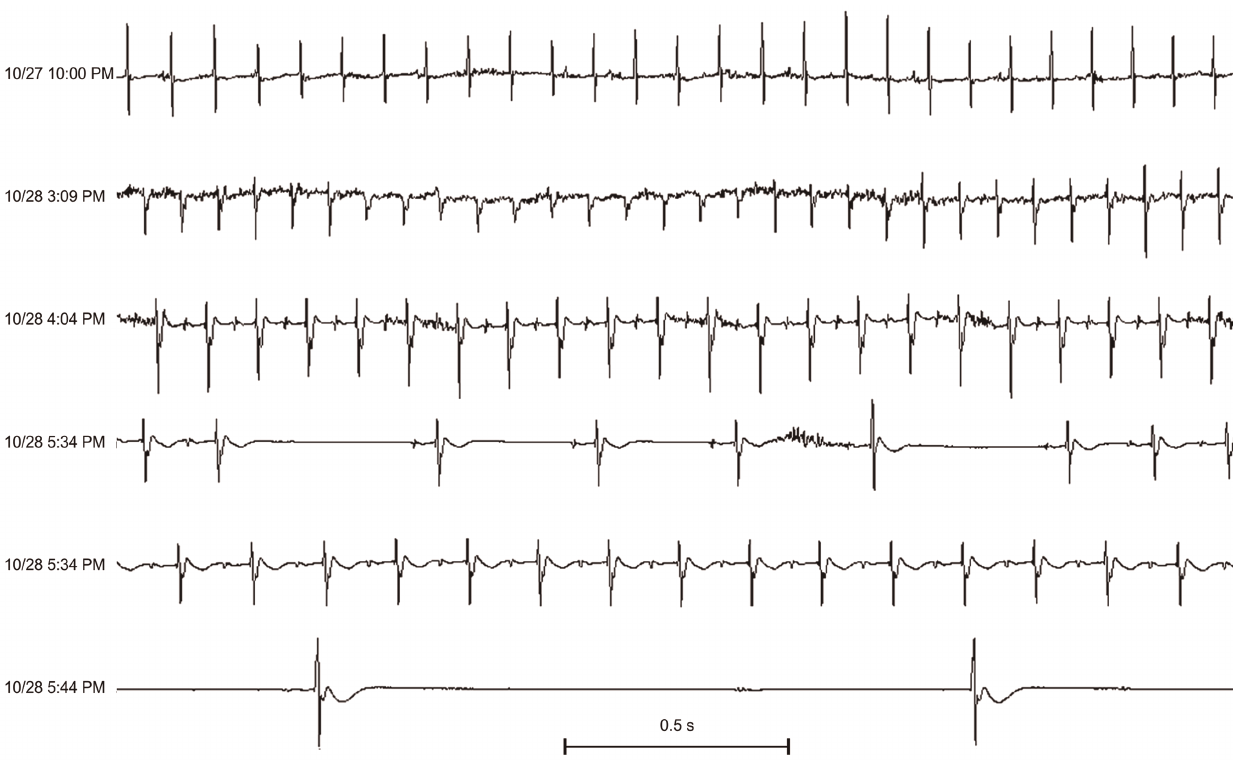
Figure 4. Bradycardia and high grade block develop just prior to death after weekly LPS. Telemetry tracings from a mouse that died 57 days after weekly LPS 20 mg/kg i.p. Each strip is 2.5 seconds. The top panel shows the baseline ECG at 10 pm, 18 hours prior to death, with a heart rate of 640 beats per minute (bpm). The mouse had normal activity. The remaining panels show telemetry tracings during last two hours before death. At 3:09 pm, there was a junctional tachycardia at 720 bpm with a shift in the QRS axis, consistent with increased automaticity from another region or fascicle. One hour later at 4:04 pm, sinus rhythm returned (with p waves) at 540 bpm. However 1.5 hours later at 5:34 pm, episodes of high grade block occurred with sustained bradycardia at 384 bpm, then 10 minutes later at 5:44 pm progressive high grade AV block and an idioventricular escape rhythm just prior to death.